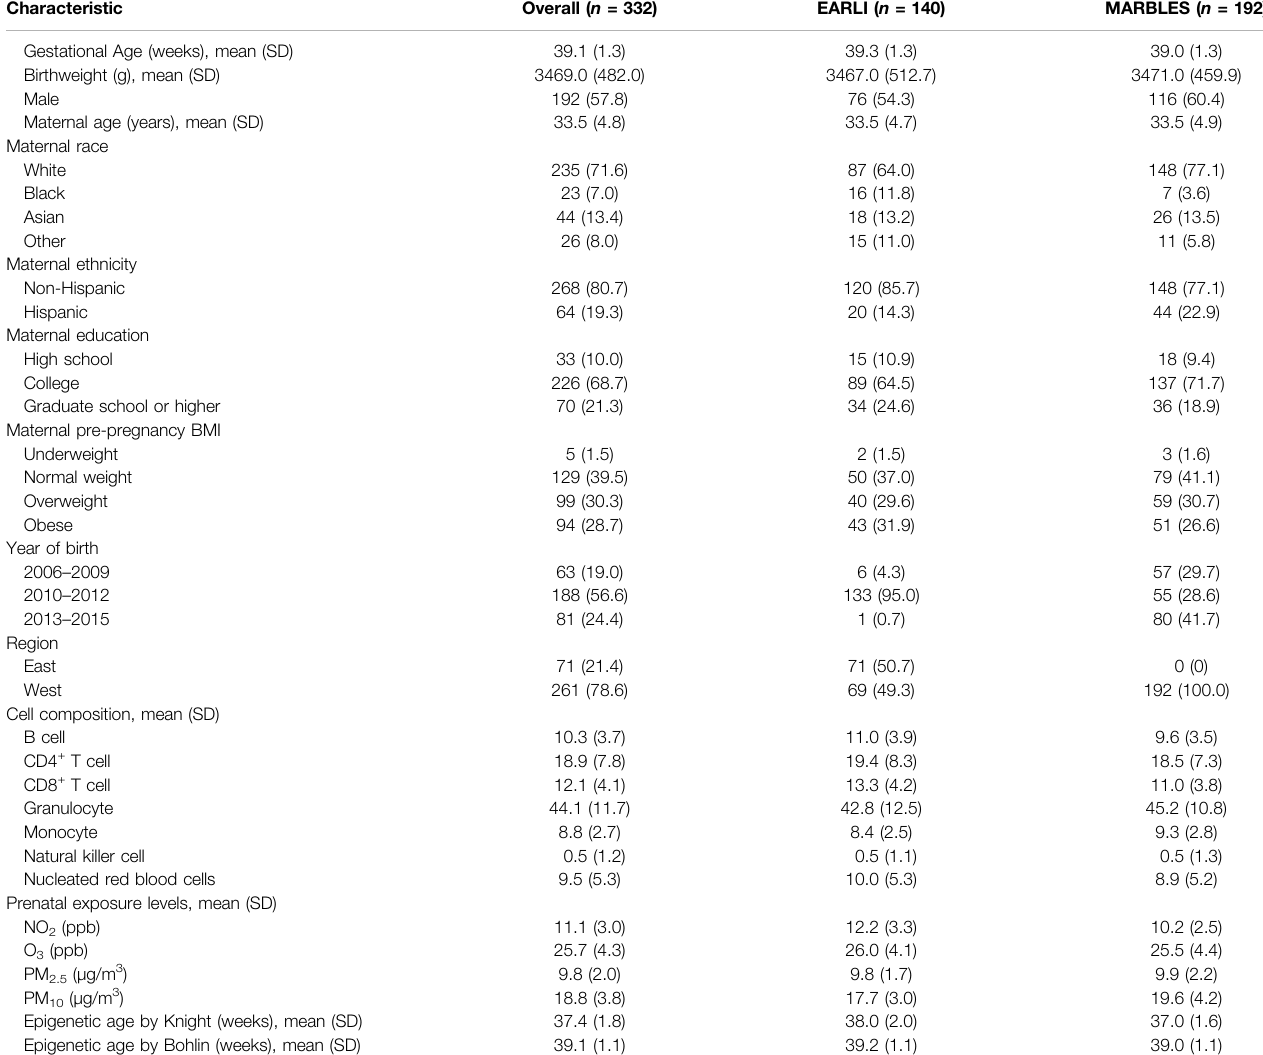
We also tested for the trimester-speci fi c exposures and epigenetic aging associations ( Table 3 ) in individual models and models mutually adjusted for all 3 trimester exposure periods. Trimester-speci fi c exposures to NO 2 and O 3 were not signi fi cantly associated with epigenetic age acceleration/ deceleration at birth for both Knight and Bohlin clock.